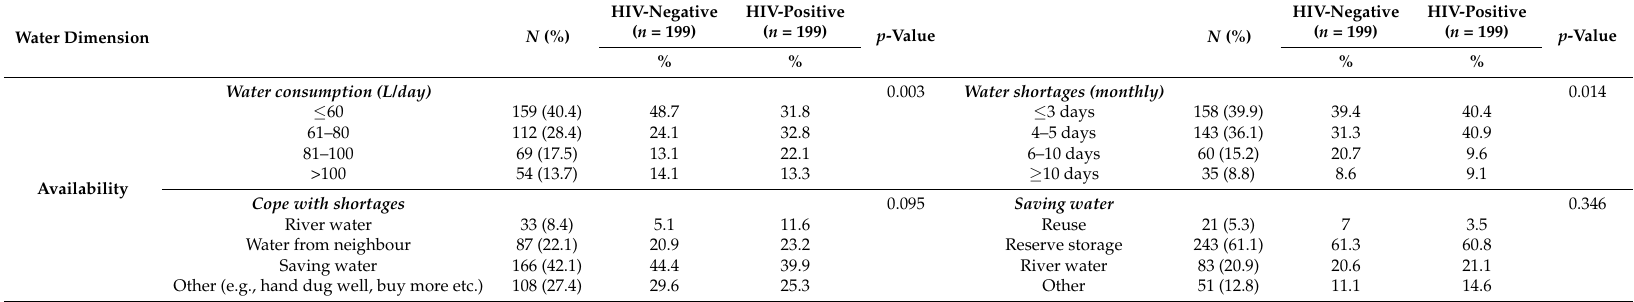
Table 3. A comparison of water availability among the HIV-negative and HIV-positive groups in Wukro ( N = 398). Water